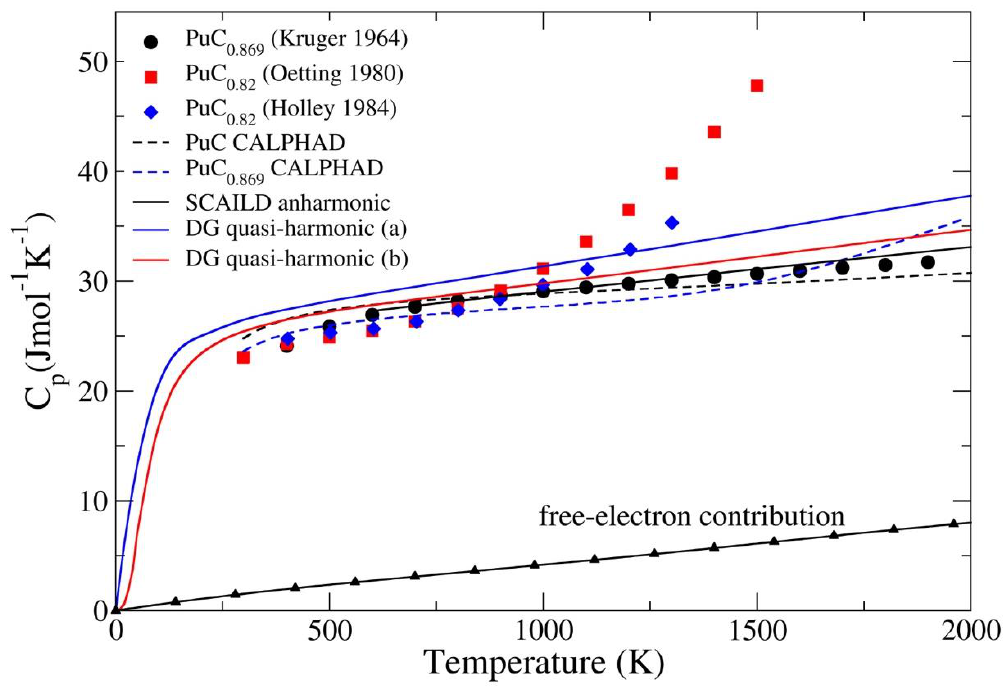
Figure 7. Measured and calculated specific heats at constant pressure, C p . The solid square (red), diamond (blue), and circle (black) are experimental data sets from references [64–66]. Dashed lines refer to results from CALPHAD. The solid black, blue, and red lines without symbols refer to our best anharmonic theory and two parameterizations of Debye–Grüneisen quasi-harmonic theory. The solid black line with triangles shows the calculated free-electron contribution to C p .